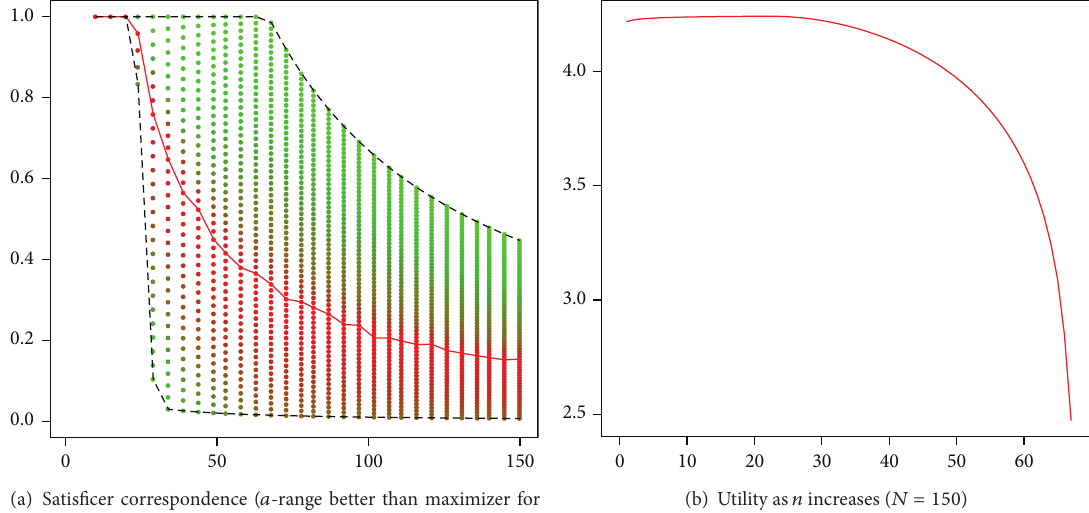
Figure 2: Satisficing behavior and welfare, case of normal distribution 𝑁(500, 50)